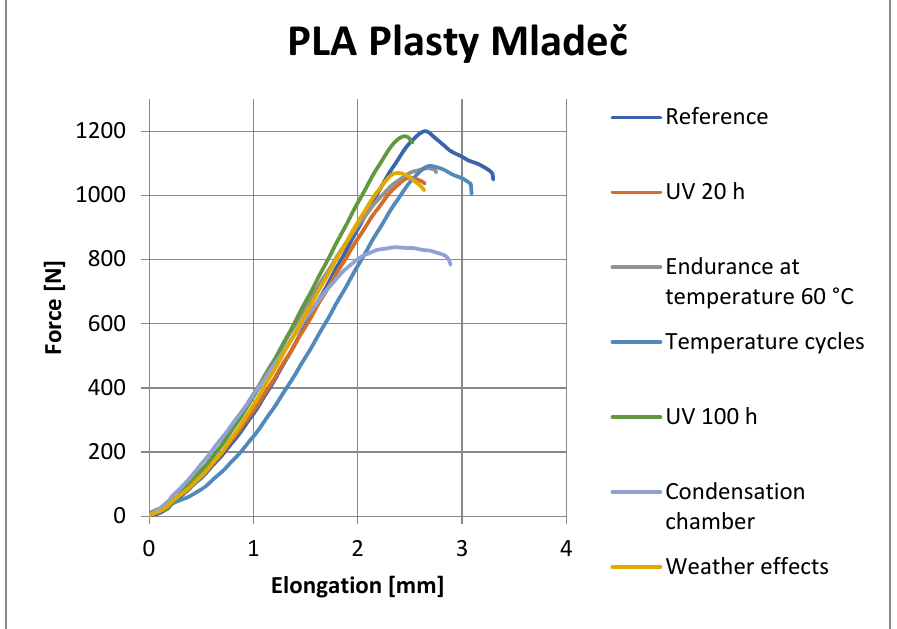
Figure 8. Tensile curves of PLA Plasty Mlade č samples.